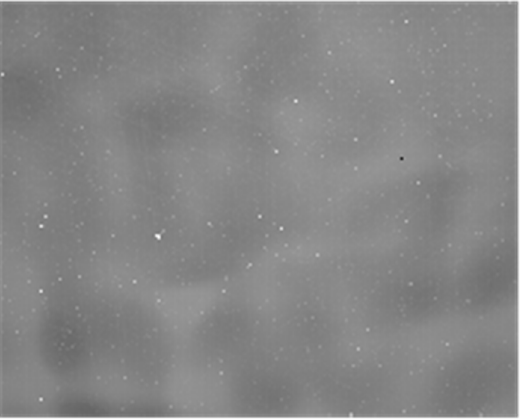
Figure 21. Target image of the sky scene to be corrected by the two sets of correction coefficients.